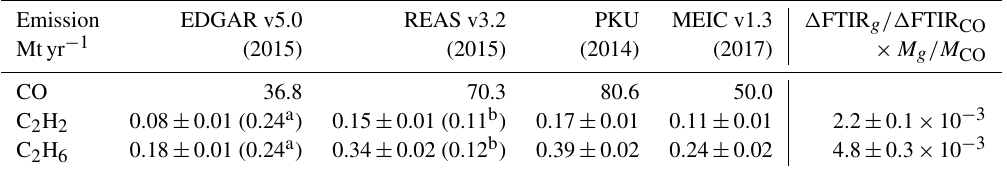
Table 6. The anthropogenic emissions of CO in the FSEA from EDGAR v5.0 and REAS v3.2 in 2015, PKU in 2014, and MEIC v1.3 in 2017. C 2 H 2 and C 2 H 6 emissions are derived from the FTIR measurements at Xianghe together with the CO